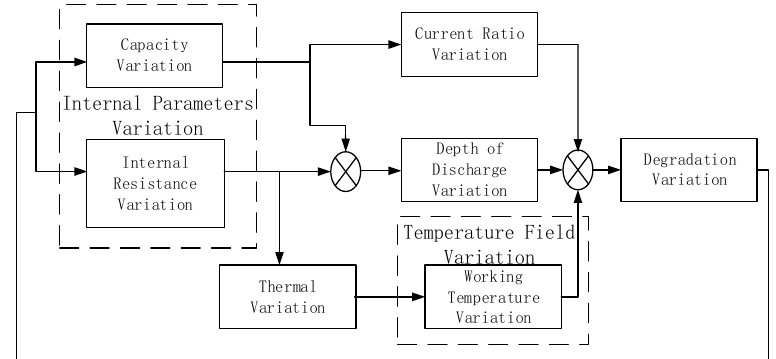
Figure 1. The coupling relationship between the internal and external factors.